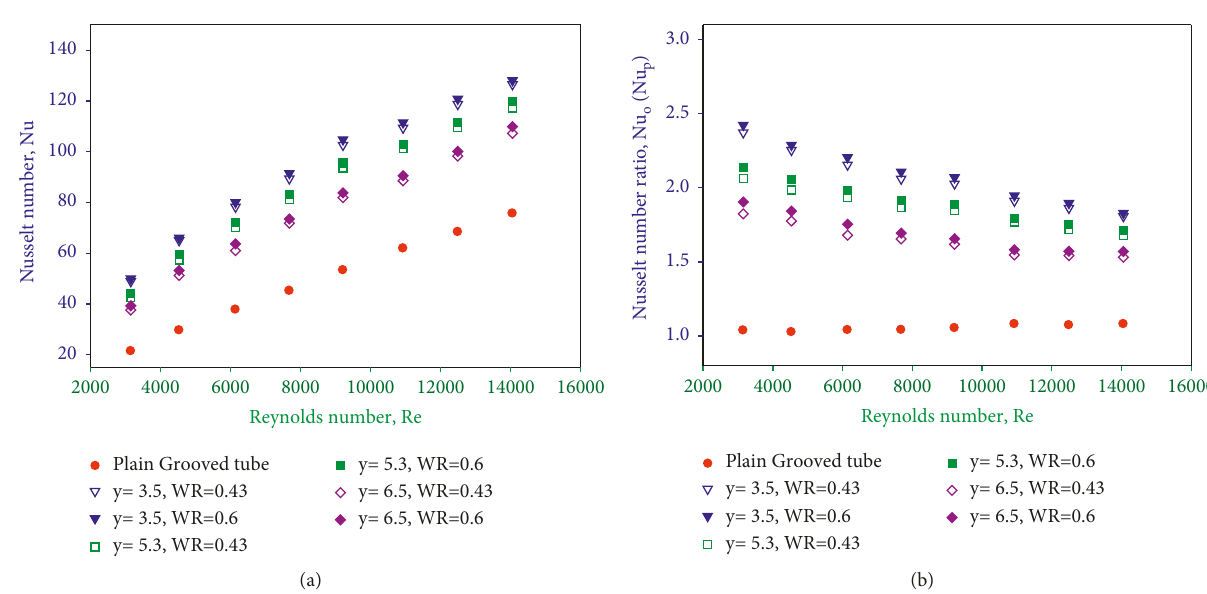
Figure 8: Nusselt number of WCTT: (a) Nu vs. Re. (b) Nu